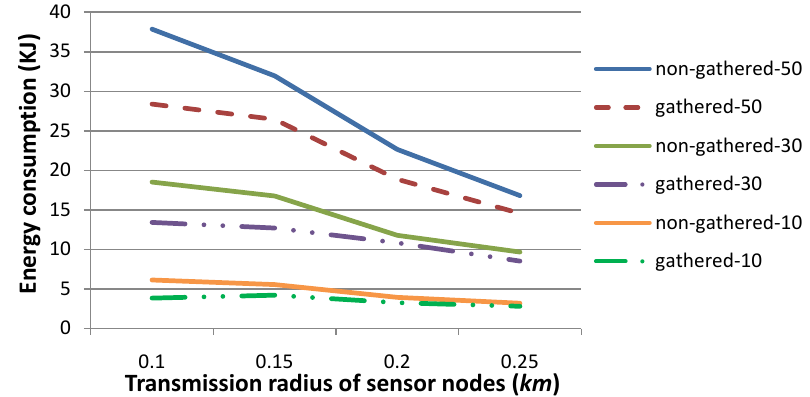
Figure 10. Comparison of the energy consumption when the transmission radius r is set to various values, for the strategies that sensory data are gathered, or not gathered, by relay nodes. This figure shows that the energy consumption for our gathered strategy is smaller than that for the traditional non-gathered strategy, especially when r is relatively